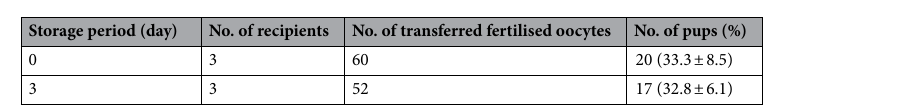
Table 1. Birth rate of fresh and cold-stored rat sperm. In the IVF, 6 female and 6 male rats were used. Ten vasectomised male rats and 6 pseudo-pregnant rats were used for embryo transfer.